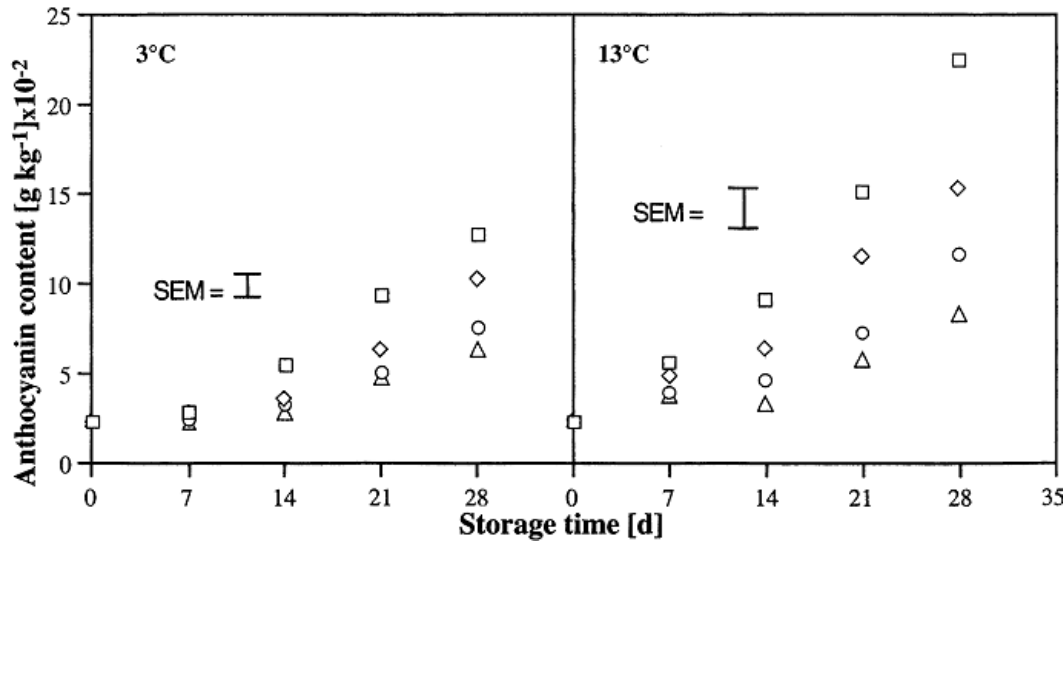
Figure 3. Effect of pre-harvest chitosan spray treatments on anthocyanin content of strawberry fruit stored at 3 (S.E.M. ± 0.57 × 10 −2 ) and 13 °C (S.E.M. ± 0.84 × 10 −2 ). Control (□); 2 gl −1 (cid:28)( ◇ ); 4 gl −1 (○) and 6 gl −1 ( △ ). Data were pooled across the number of sprays and picks and repetitions. Reproduced from Reference